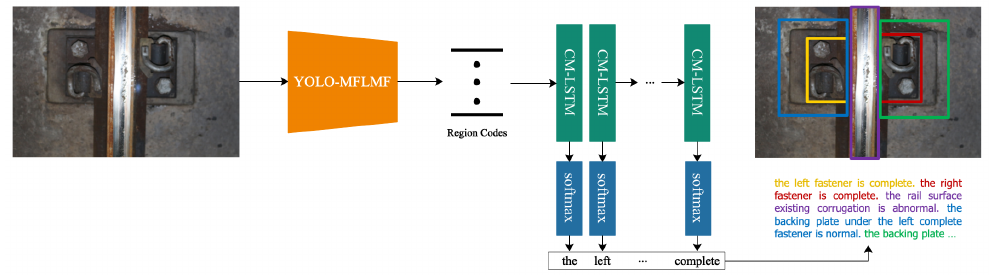
Figure 10. Network architecture of the proposed Faster RTLCap